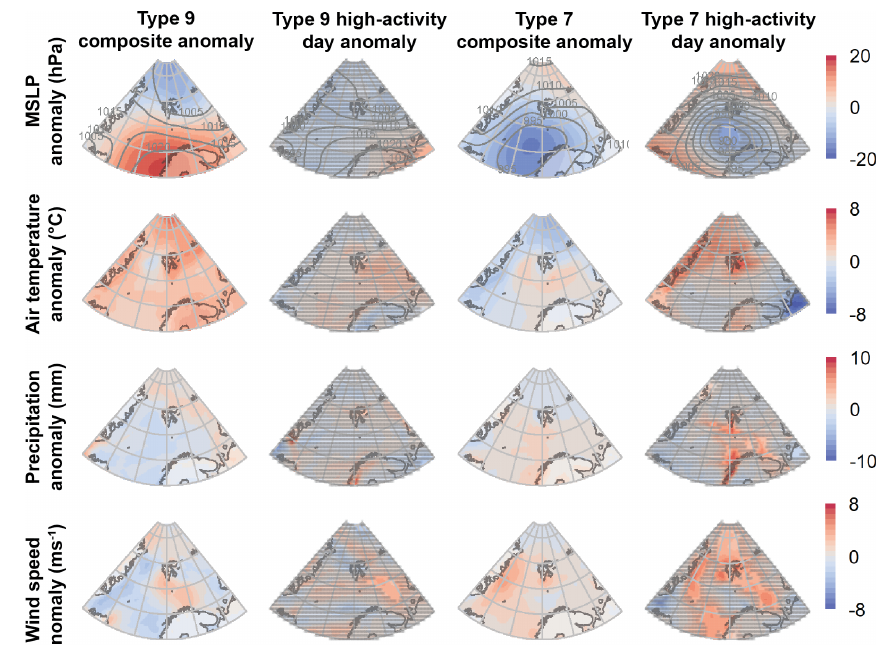
Figure 10. Composite anomalies for all Type 9 and Type 7 days versus mean winter conditions are shown in the first and third columns. Anomalies for Type 9 and Type 7 high-activity days versus the Type 9 and Type 7 composites are shown in the second and fourth columns. High-activity day anomalies that are not statistically significantly different from the respective synoptic type’s composite are indicated with dense